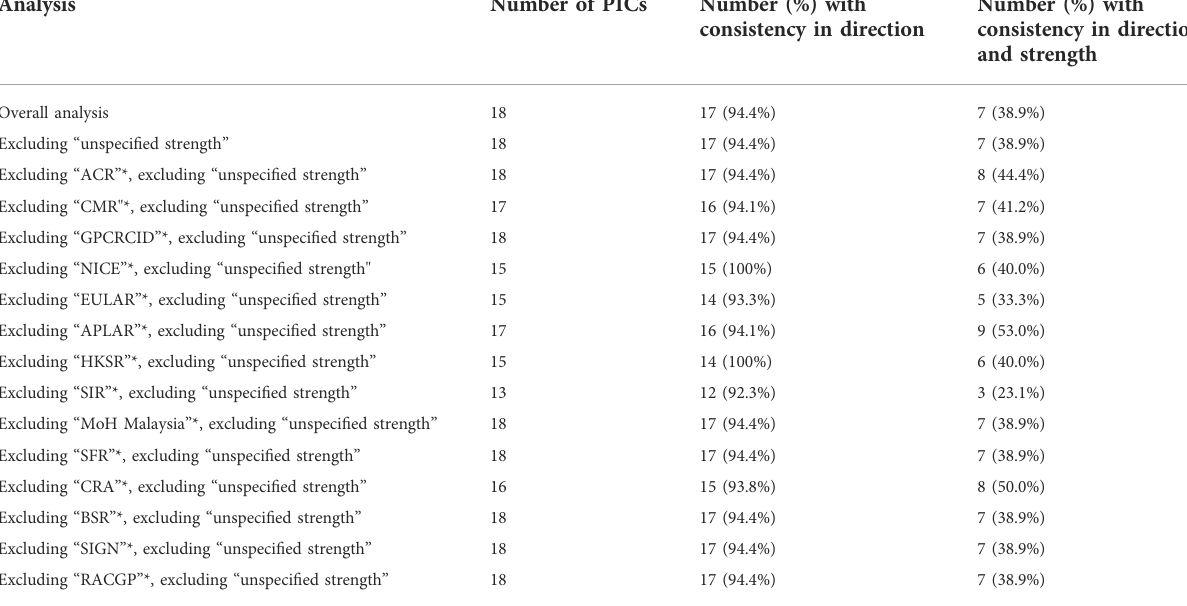
TABLE 2 Consistency of direction and strength across clinical practice guidelines with sensitivity analysis for excluding unspeci fi ed strength.